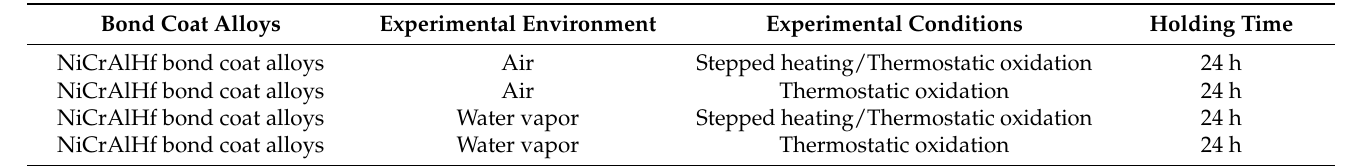
Table 1. The experimental conditions of the alloy in various atmospheres and using different heating